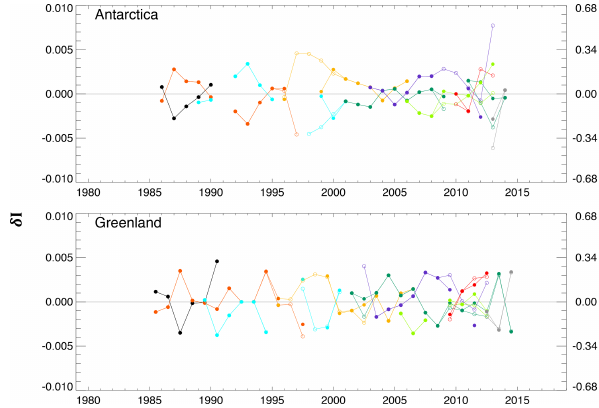
Figure 6. Same as Fig. 4 except that the merged-satellite average is